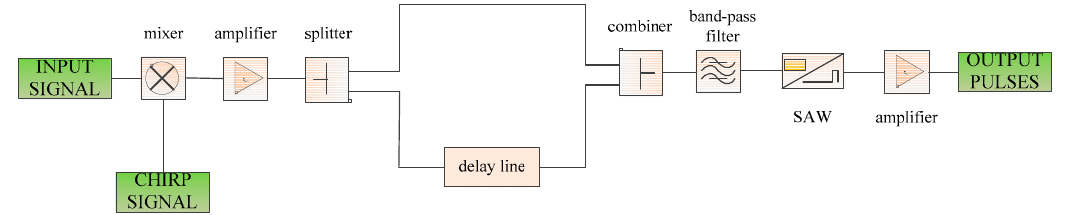
Figure 3. The structure of the time delay single M(l)-C(s) (TDS M-C)